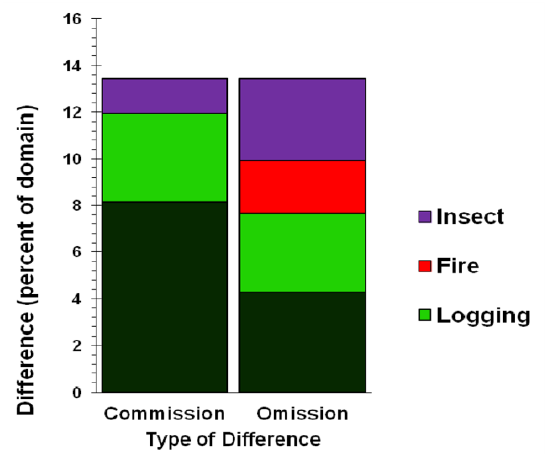
Figure 6. Error summary reported as the percent of